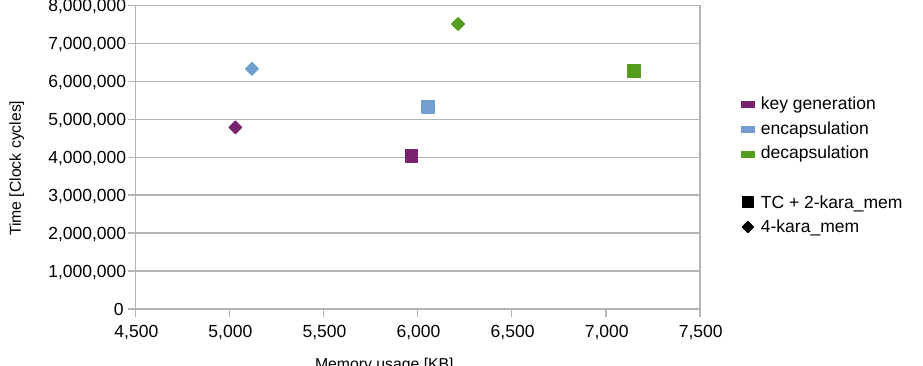
Figure 4: Time vs memory for different combinations of optimizations in Cortex-M0.